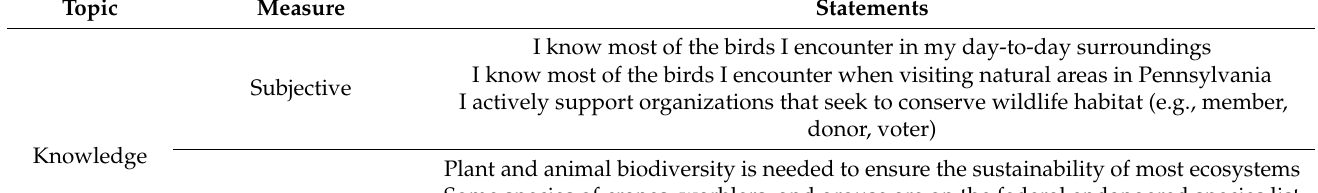
Table 3. Statements used to measure knowledge and perceptions about bird conservation on a five-point Likert scale.